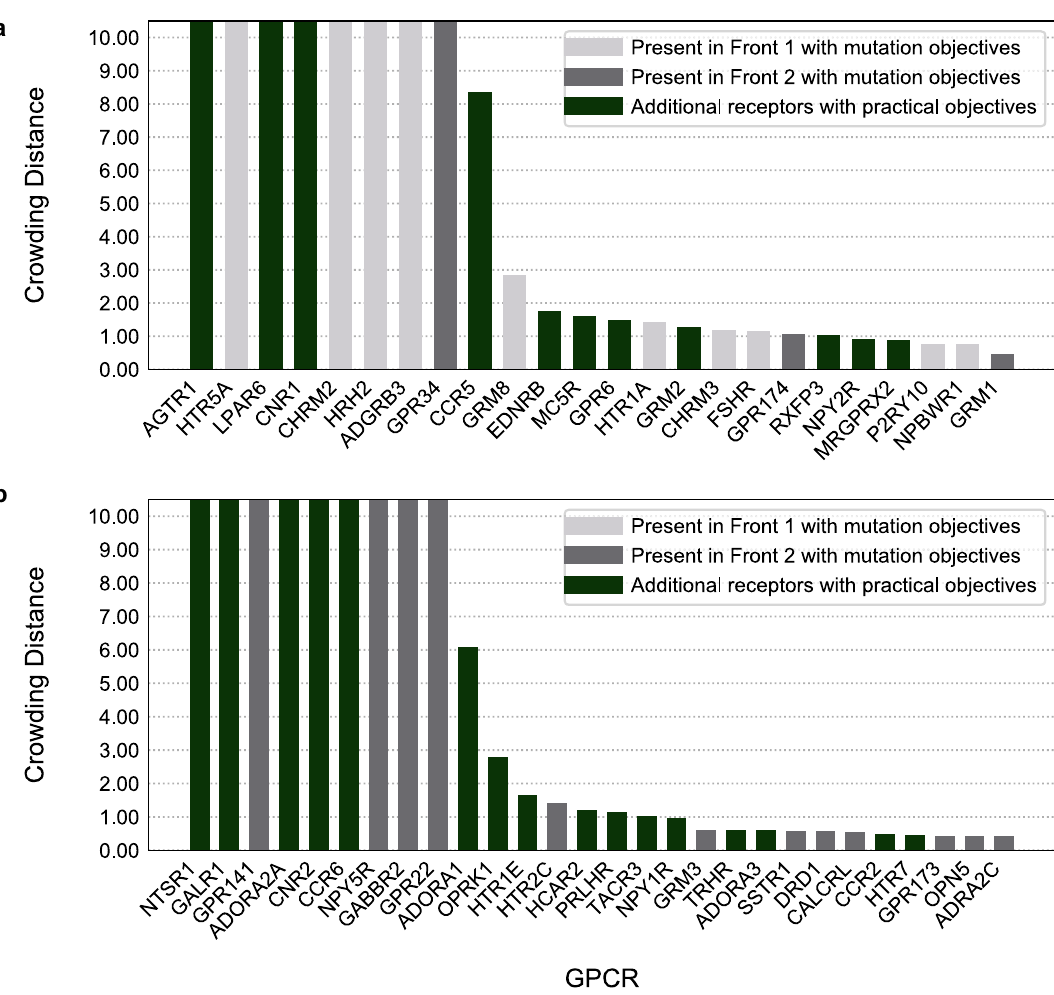
Figure 5. Crowding distances of the first and second Pareto fronts. ( a ) First Pareto front, consisting of 24 GPCRs. ( b ) Second Pareto front, consisting of 28 GPCRs. On the x-axis the gene names of GPCRs are shown, while on the y-axis their crowding distance is shown. Crowding distance was cut-off at 10, as the differences between these high-scoring receptors become negligible above that threshold. In grey, GPCRs detected by Pareto ranking using exclusively four mutation-derived objectives (light gray for the 1st front and darker grey for the 2nd front). In green, additional GPCRs that show up in the first two Pareto fronts by adding practical objectives to the recommendation